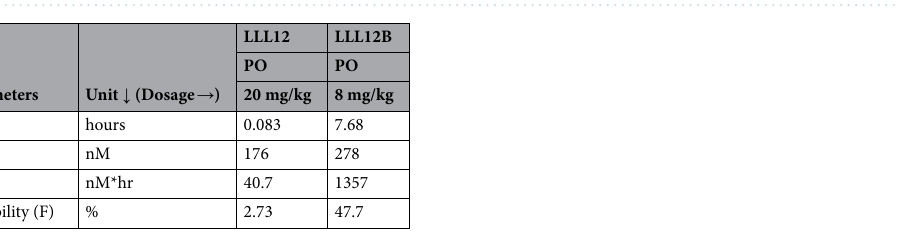
Figure 1. ( A ) The chemical structure of LLL12B. ( B ) A docking model of LLL12B (ball-and-stick) binding to the SH2 domain of STAT3 (surface representation). The image was created with graphic software called PMV in MGLTools, version 1.5.6 (URL: http:// mglto ols. scrip ps. edu/).